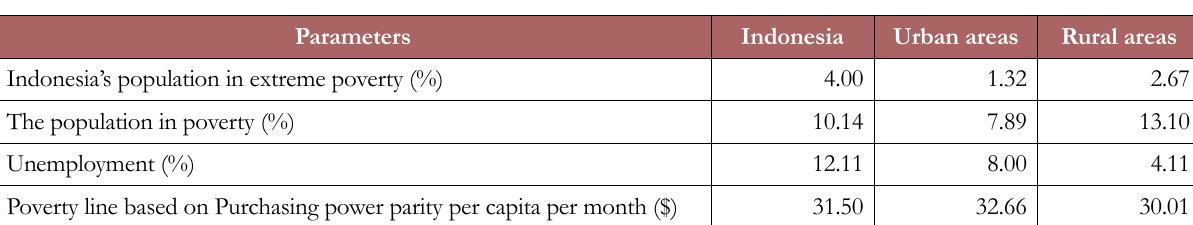
Table 1. Poverty in urban-rural areas in 2021 (Statistics Indonesia,